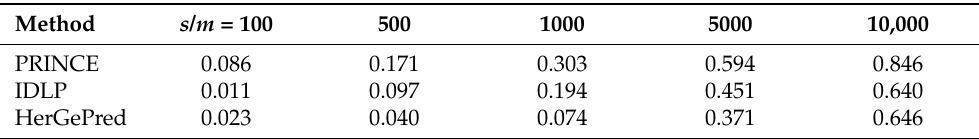
Table 10. Recall values evaluated by prediction scores for disease-gene association prediction without known disease genes from